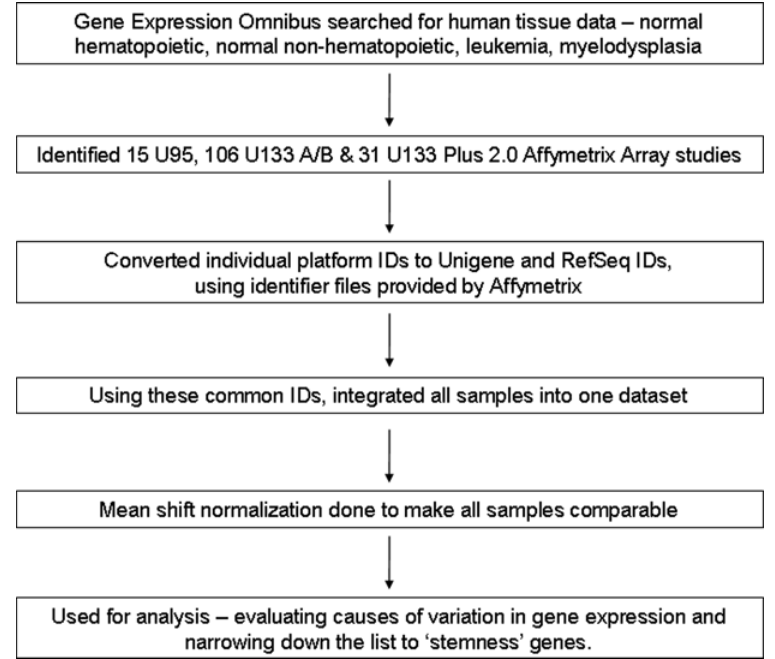
Figure 1. Schema of data collection and analysis.